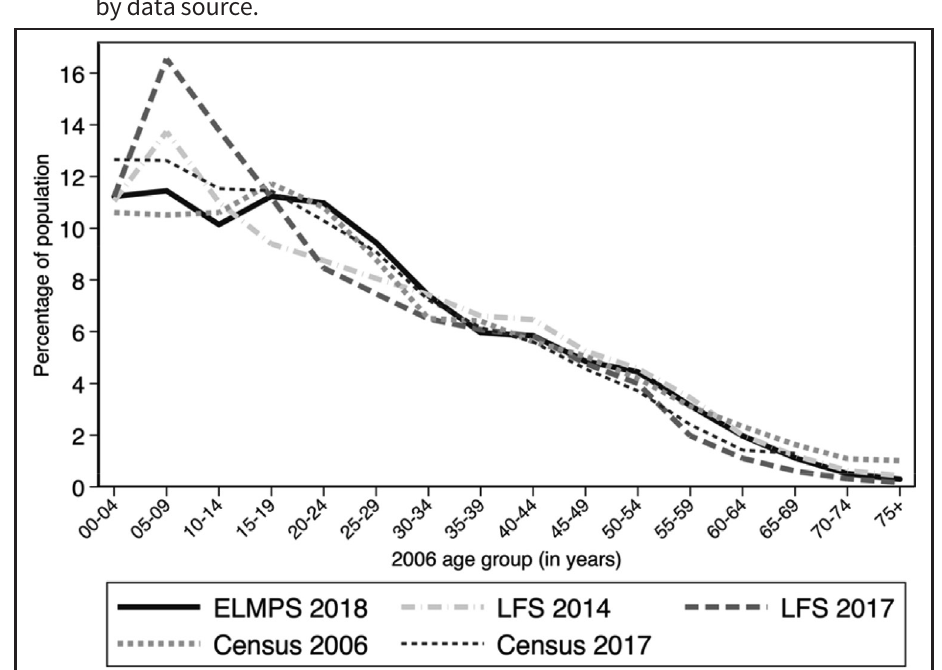
Figure 5 Comparison of age distribution, age in 2006 (percentage in 5-year age group), by data source.